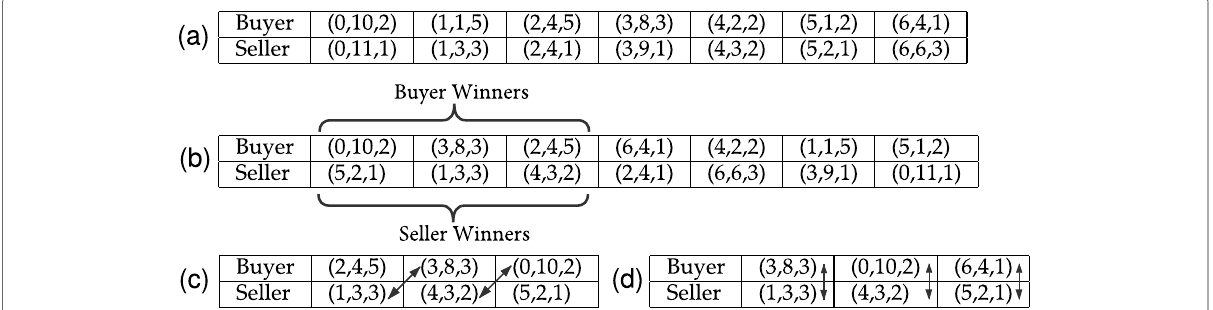
Fig. 3 Determining Winners and Pairing. We only show cloud ID, bid price and duration here. E.g. (0,10,2) stands for cloud 0 bidding price $10 and duration 2 timeslots